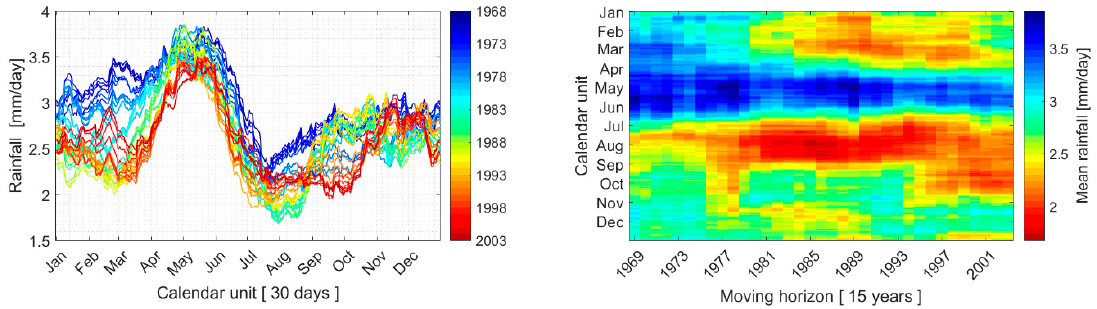
Figure 4. MASH of the daily rainfall (w = 30 days, Y = 15 years). The dates correspond to the starting year, noted Ys, for shifting horizon average, so the corresponding shifting horizon period is from the starting year Ys to Ys + 15 years. Due to the 15 years moving average window, the abscissa finished in 2003.